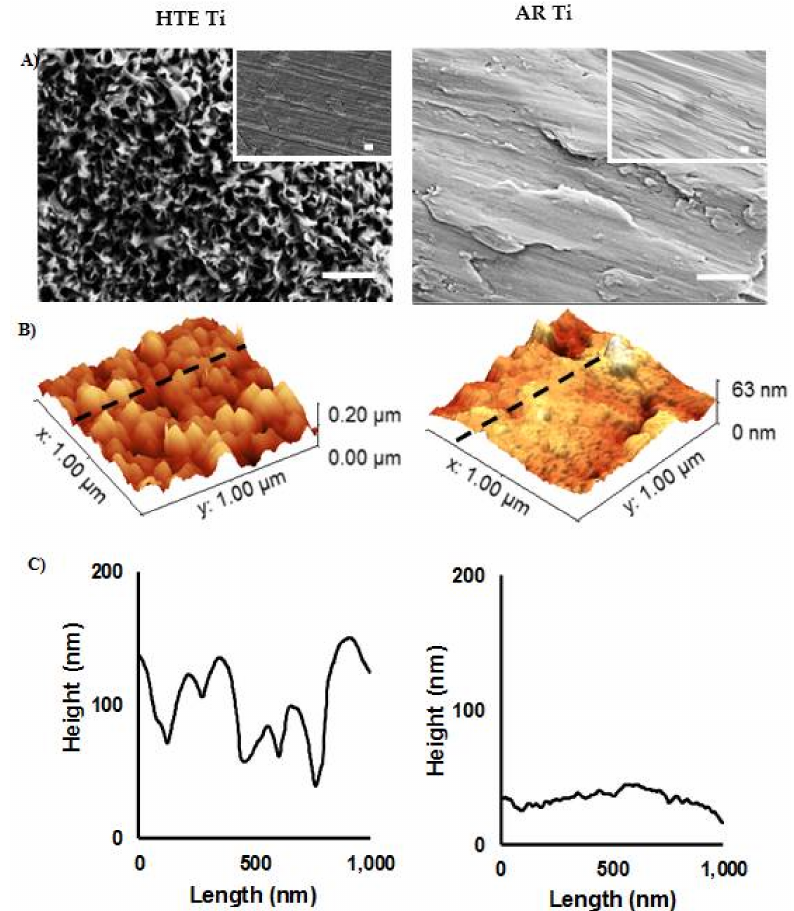
Figure 1. Surface topographic characterisation of as-received and nanostructured titanium. ( A ) SEM images of the surfaces of AR (right) and HTE Ti (left) (scale bar = 400 nm). Insets are images taken at 5000 × (scale bar = 2 µ m). ( B ) Typical 3D AFM images and ( C ) corresponding surface profiles of AR and HTE Ti surfaces over 1 × 1 µ m 2 scanning areas, showing a significant change in surface nanoarchitecture resulting from the hydrothermal